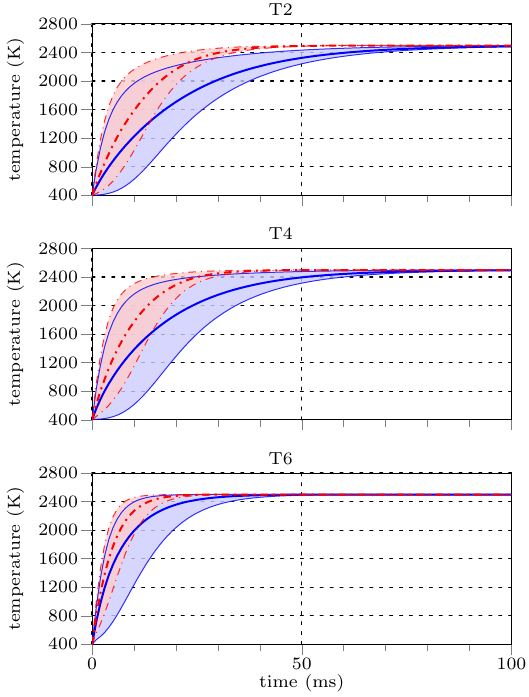
Figure 4. Comparison of mean cluster temperature (solid) and range of individual particle tempera- tures (shaded area) during the heat-up at 13 m/s relative velocity ( Re P = 7.50), as defined in Table 1. red ( ): convective and radiative region coupling; blue ( ): convective region